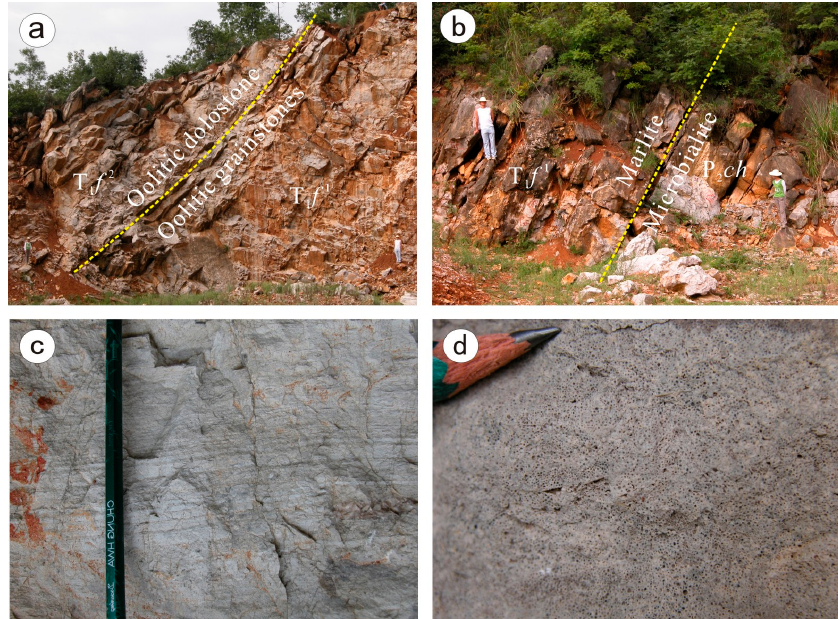
Figure 2. Field and macroscopic features of rocks from the Yudongzi outcrop. ( a ) Boundary between oolitic grainstone of T 1 f 1 and oolitic dolostone of T 1 f 2 . ( b ) Boundary between marlite of T 1 f 1 and microbialite of P 2 ch. ( c ) Banded gray oolitic dolostones in the bottom of T 1 f 2 . ( d ) Residual oolitic dolostones in the middle of T 1 f 2 .